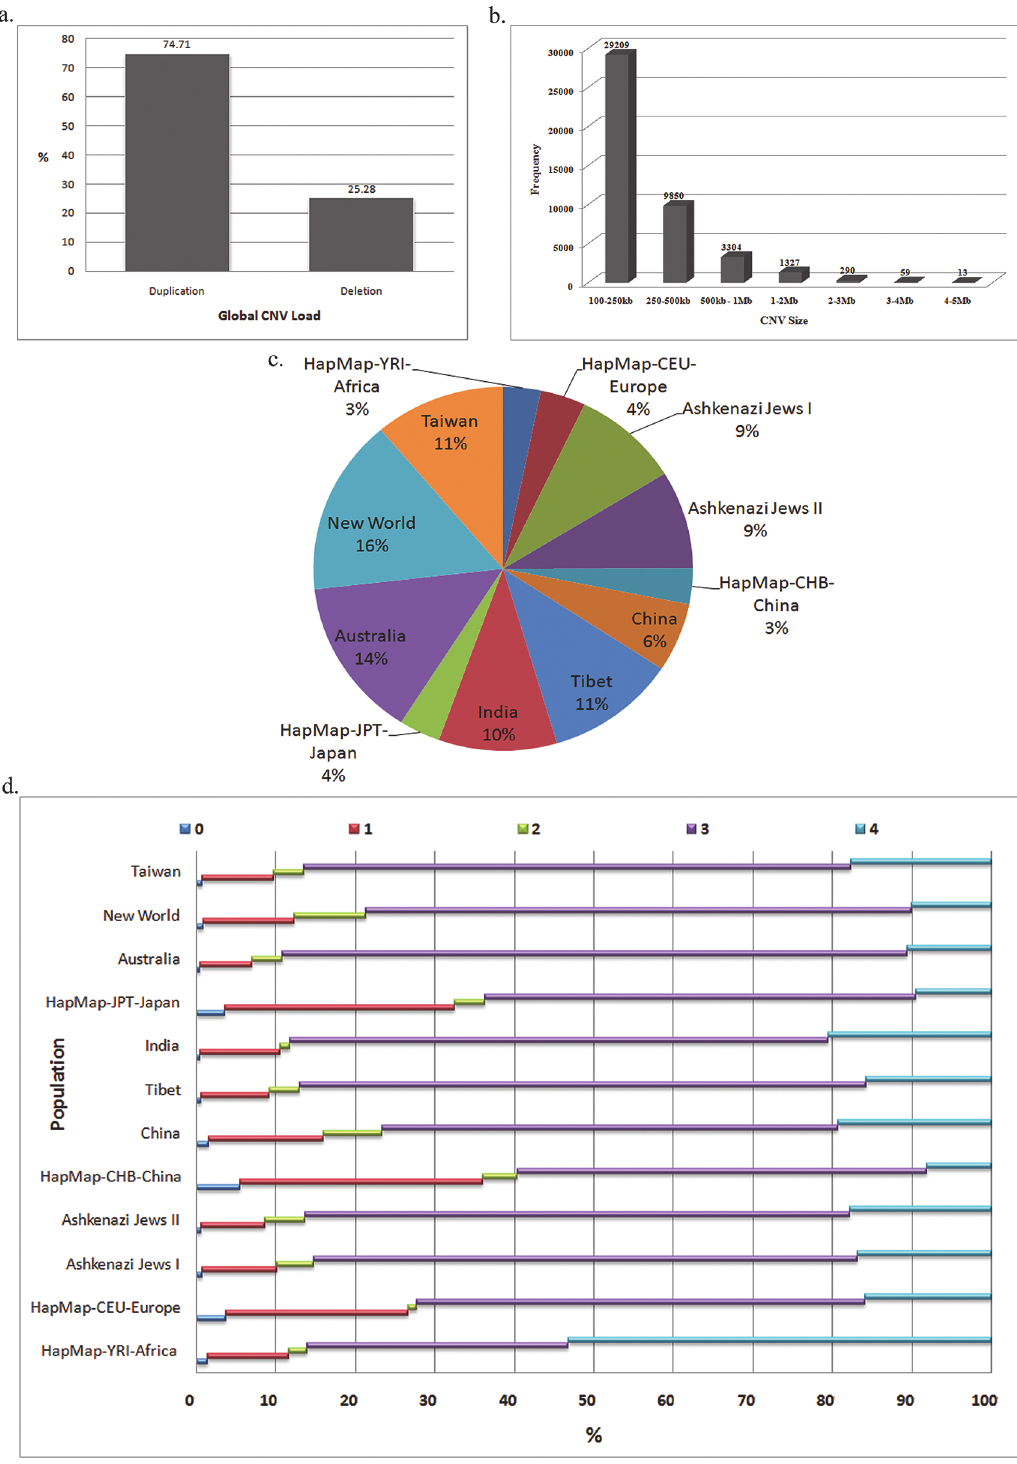
Fig 1. Distribution of CNV load and size across populations. a) Percent of Global CNV load across all populations. A total of 44109 CNVs across the genome showing the frequencies of gain polymorphisms (74.71%) and the loss polymorphisms (25.28%). b) Frequency of CNV size burden across populations. Bars indicate the number of CNVs for 7 different size ranges. 66.3%, 22.3%, 7.5%, 3%, 0.65% and 0.1% were found in the size range of 100- 250kb, 250-500kb, 500kb-1Mb, 1-2Mb, 2-3Mb and 3-4Mb size respectively. c) Pie chart indicating percent of global share of CNVs identified in 12 populations. Each color represents an individual population and the percent of CNVs identified in that population. d) CN states of 0, 1, 2, 3 and 4 for all